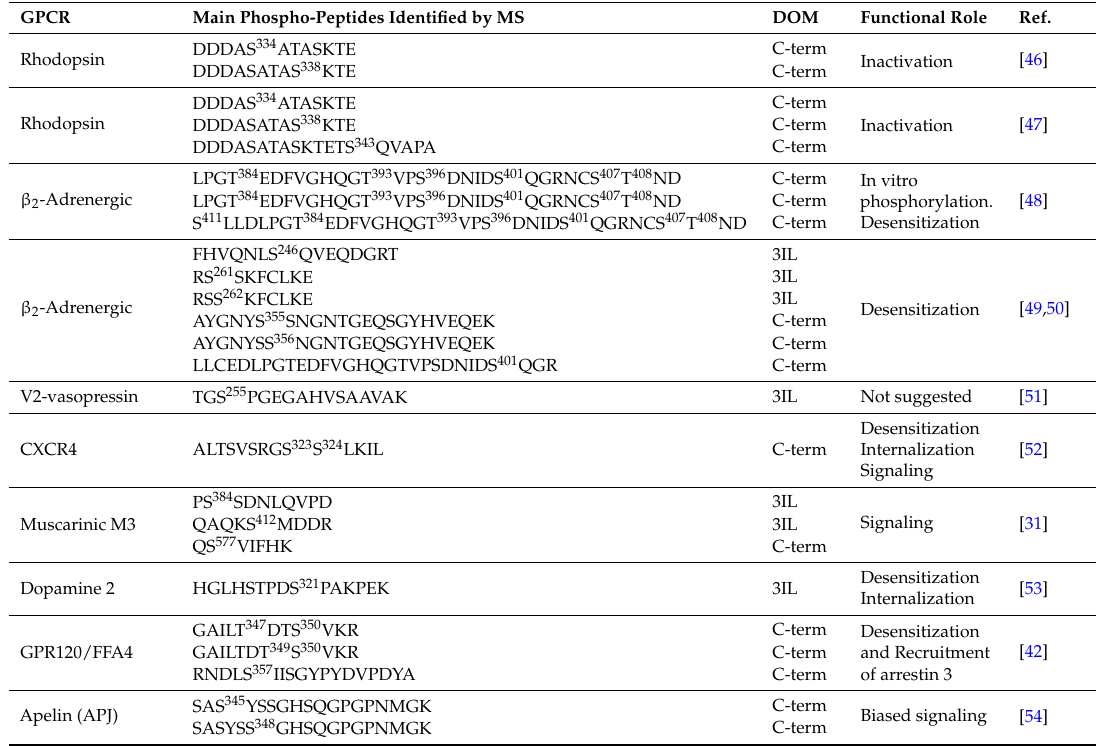
Table 1. G protein-coupled receptor (GPCR) studied using mass spectrometry. Amino acids in red indicate phosphorylation sites. Domain (DOM), carboxyl-terminus (C-term), third intracellular loop (3IL), references (Ref.).